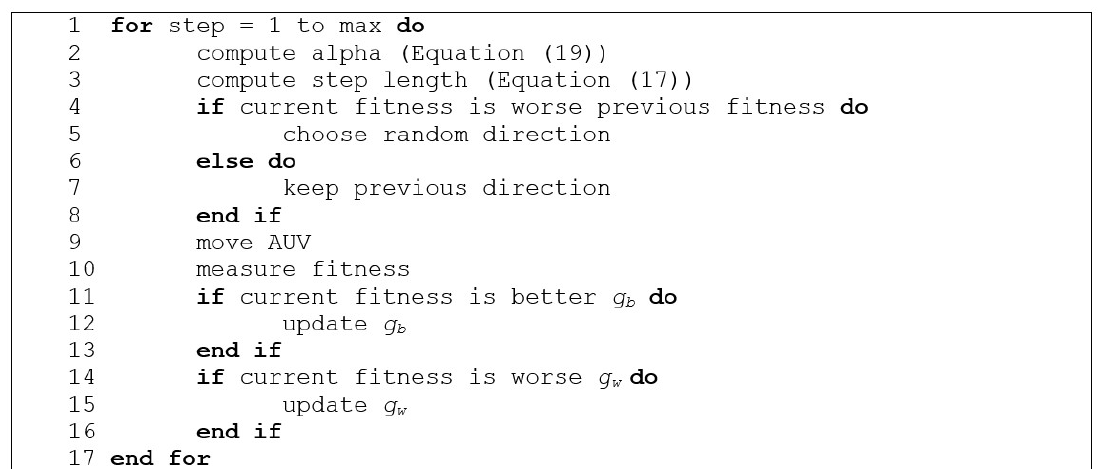
Figure 15. Pseudocode of inertia Levy-flight (ILF) search algorithms, adapted after [48].